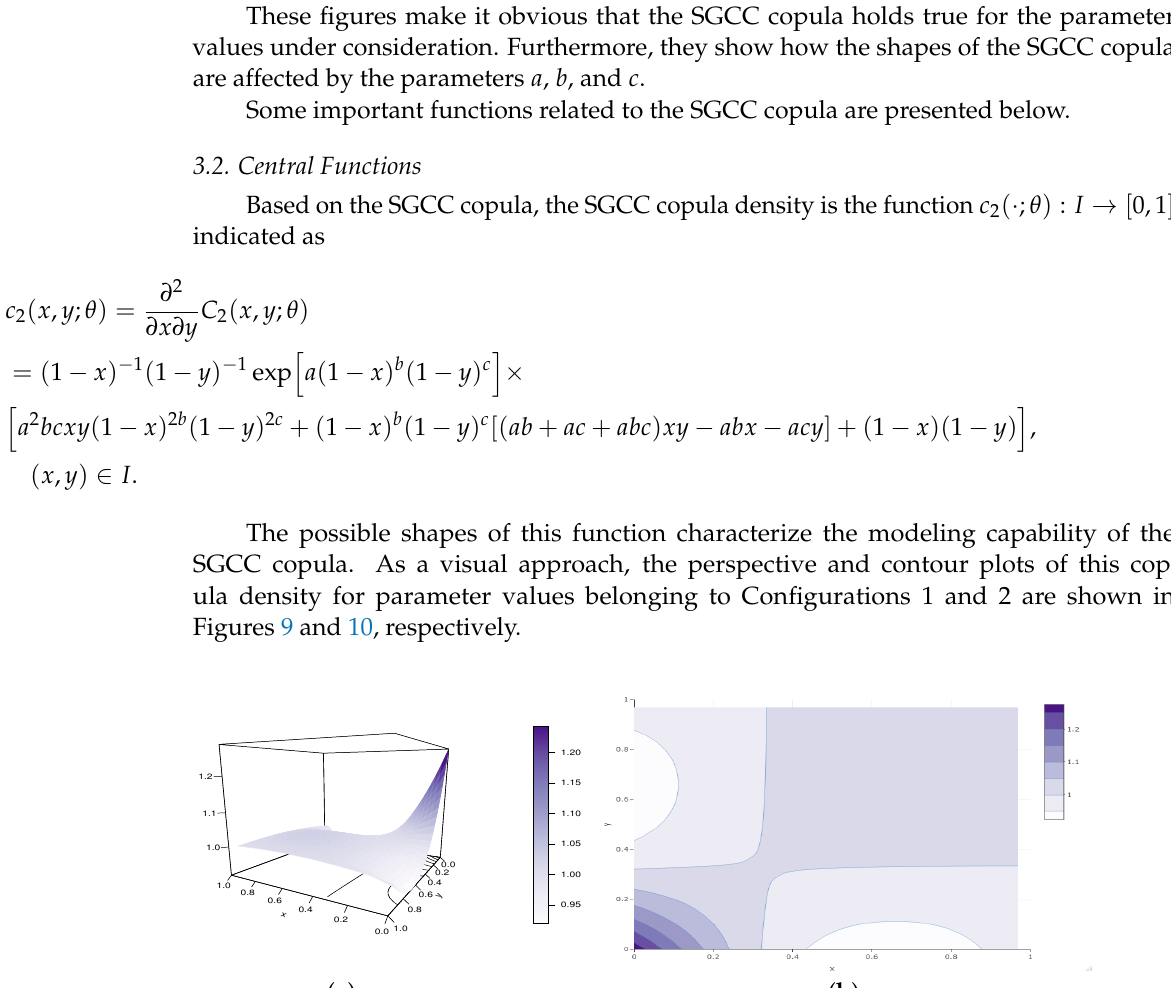
Figure 8. Illustrations of the ( a ) perspective plot and ( b ) contour plot of the SGCC copula for the following configuration: a = − 1/2, b = 2, and c = 1, belonging to Configuration 2.